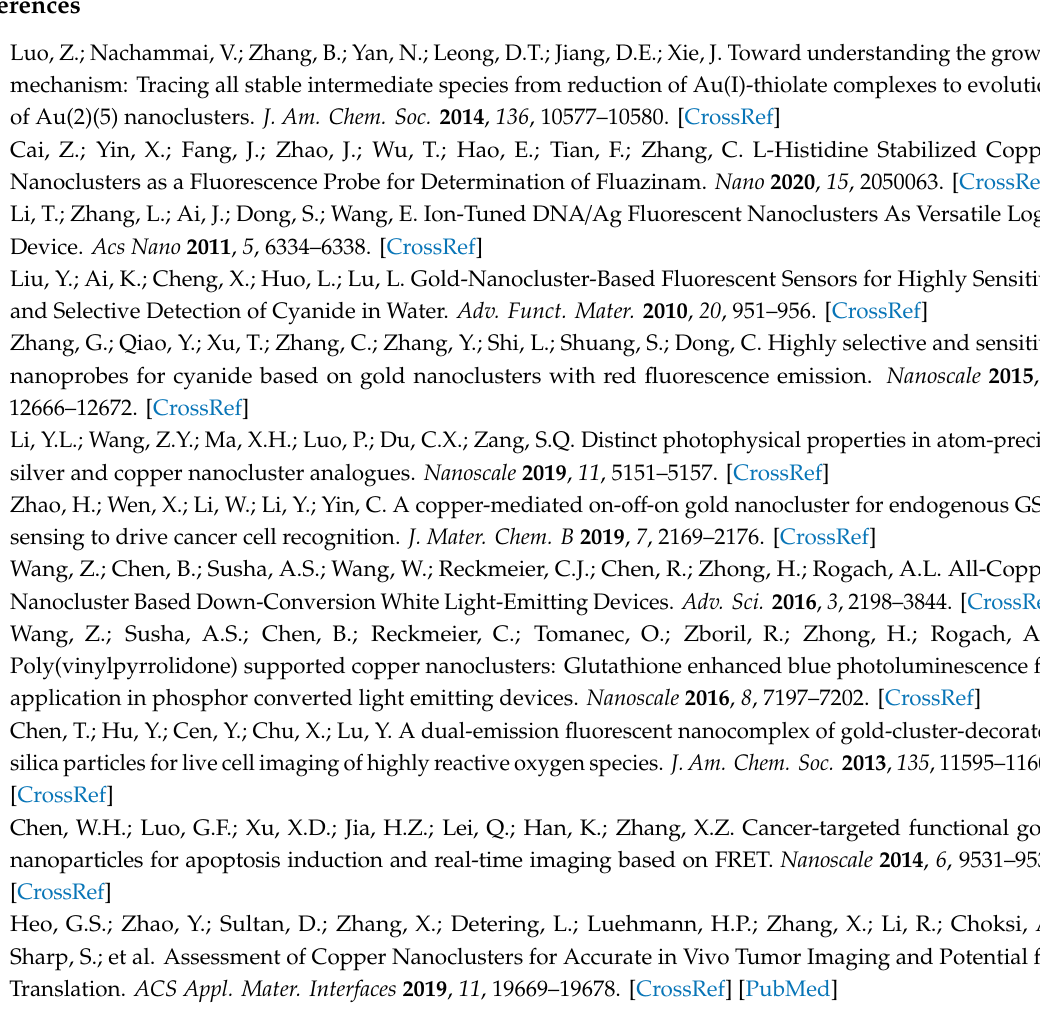
Figure S1: The photographs of Cu NCs under ordinary daylight (A) and UV-irradiation (B); Figure S2: Fluorescence emission spectra of GSH, Cu 2 + solution and mixture of GSH and Cu 2 + ; Figure S3: A high resolution TEM image of Cu NCs@GSH ;Figure S4: (A) Fluorescence excitation (dash line) and emission (solid line) spectra of Cu NCs@GSH in water (blue) and solid (black) state; (B) The photographs of Cu NCs@GSH solid and redispersed in water under daylight (above) and 365-nm UV light (below), Figure S5: (A) The fluorescence emission spectra and (B) Histogram of Cu NCs@GSH in di ff erent vol% ethanol: water mixture, Figure S6: Images of HEK293T cells incubated without Cu NCs obtained (A) under bright field and (B) at the excitation wavelength of 380 nm. All authors have read and agreed to the published version of the